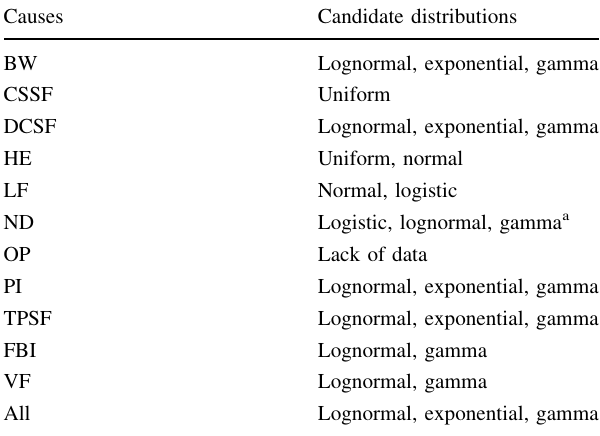
Table 4 Candidate distributions for different